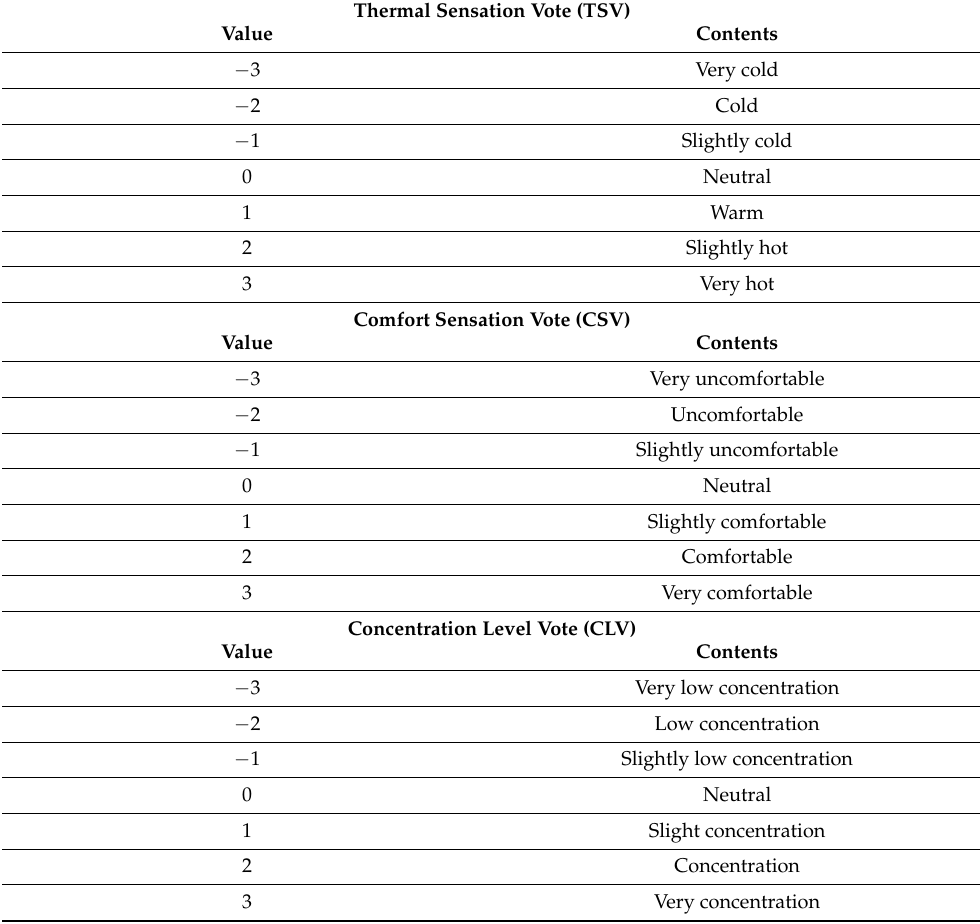
Table 10. Subjective questionnaires.